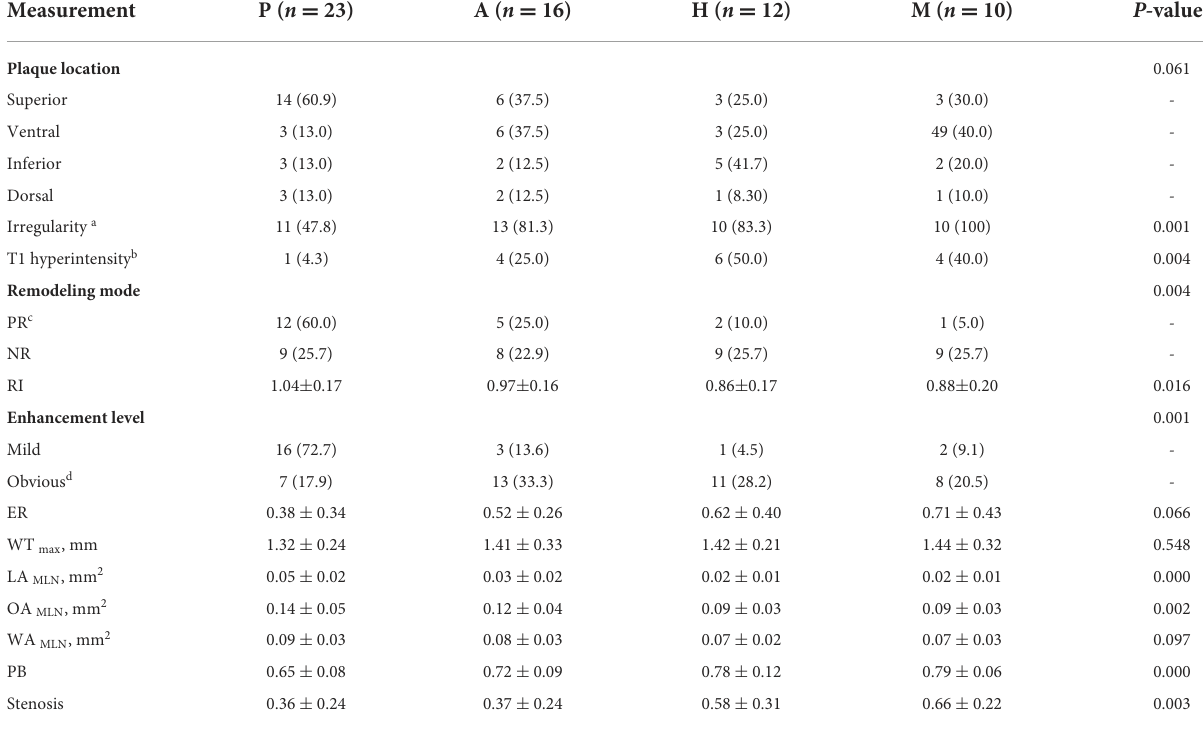
TABLE 3 Culprit plaque characteristics of the different stroke mechanism subtypes of patients with symptomatic middle cerebral artery (MCA) M1. Measurement P ( n = 23) Plaque